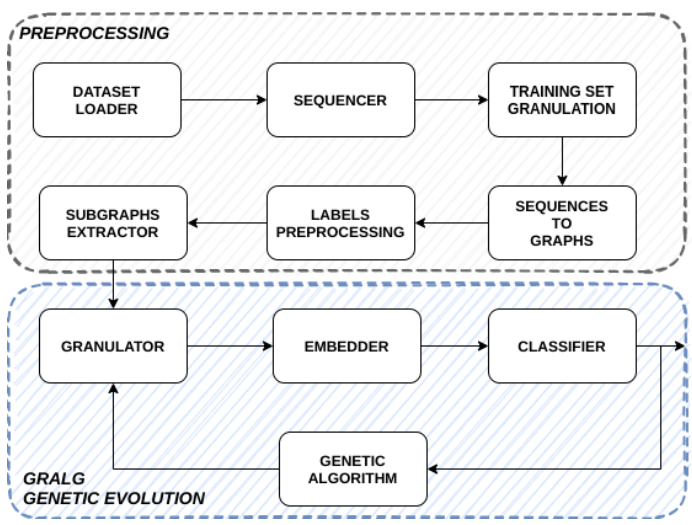
Figure 2. GRALG optimization